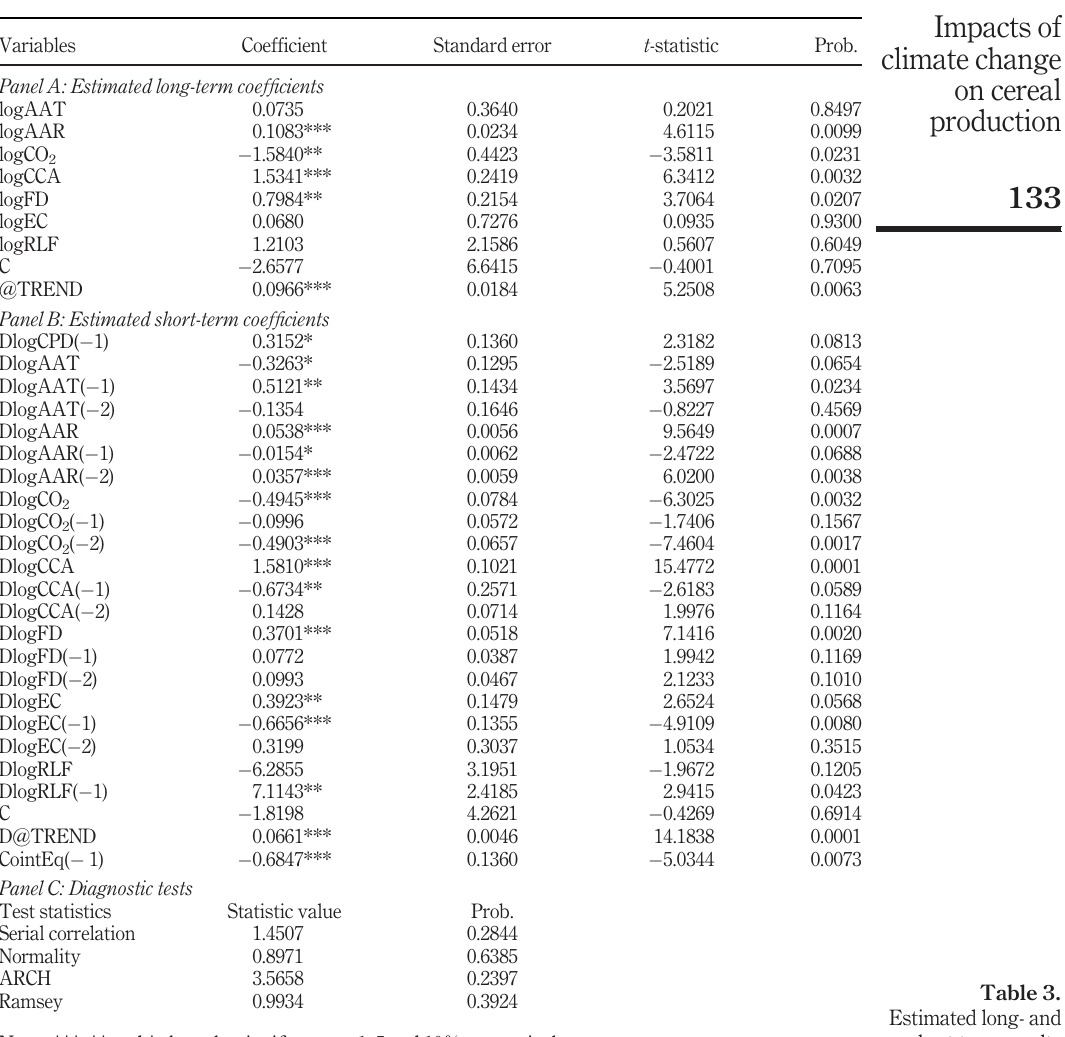
Table 3. Estimated long- and short-term